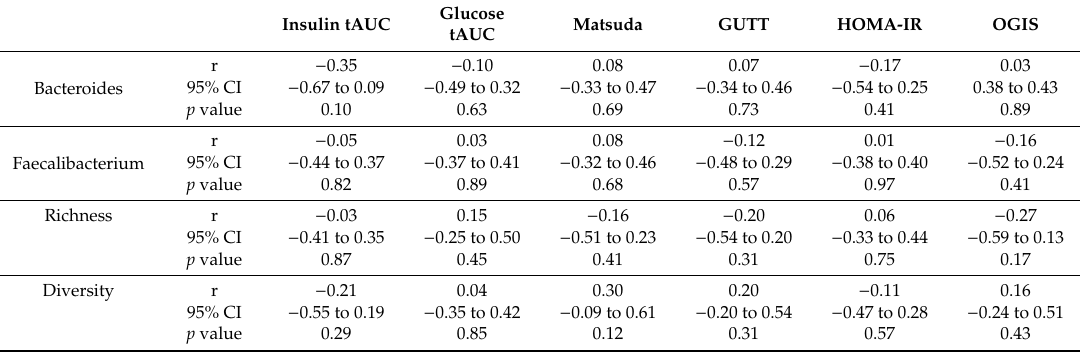
Table 2. Correlation coe ffi cients for selected genera and indices of insulin sensitivity. Glucose Insulin tAUC Matsuda GUTT HOMA-IR tAUC